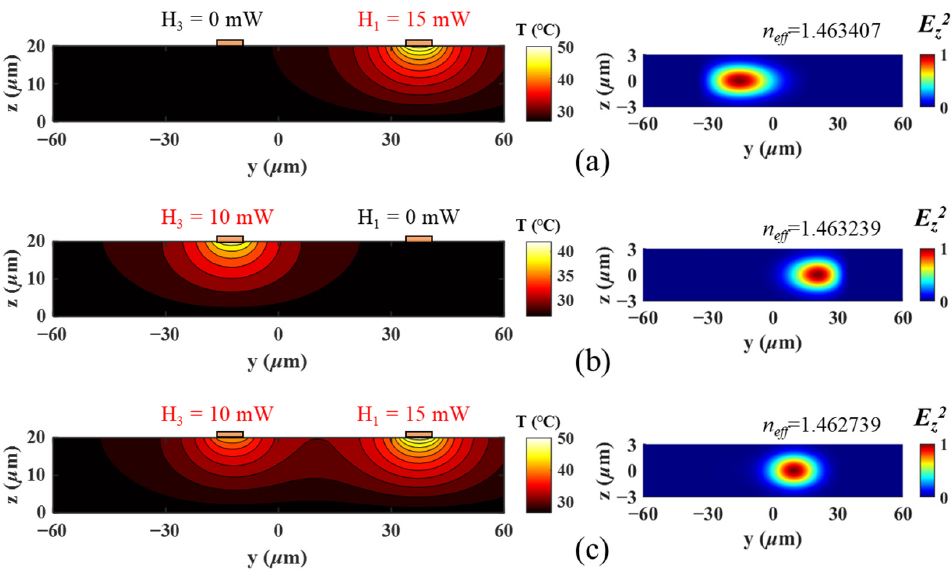
Figure 3. The temperature gradient and the field profile of the fundamental eigenmodes under different thermal configurations: ( a ) H 1 = 15 mW, H 3 = 0 mW; ( b ) H 1 = 0 mW, H 3 = 10 mW; and ( c ) H 1 = 15 mW, H 3 = 10 mW.